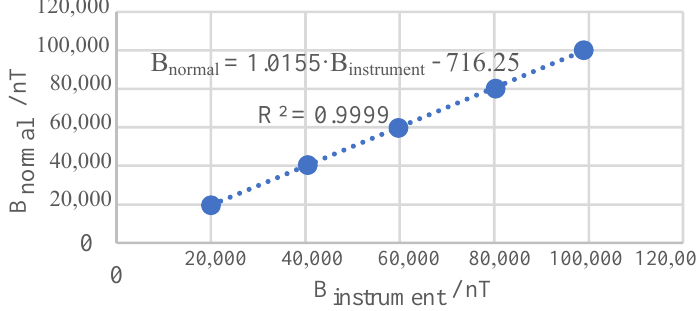
Figure 17. The fitting relationship between the standard magnetic field and the instrument indication. The noise power spectrum was tested in the laboratory, as shown in Figure 18 (left).